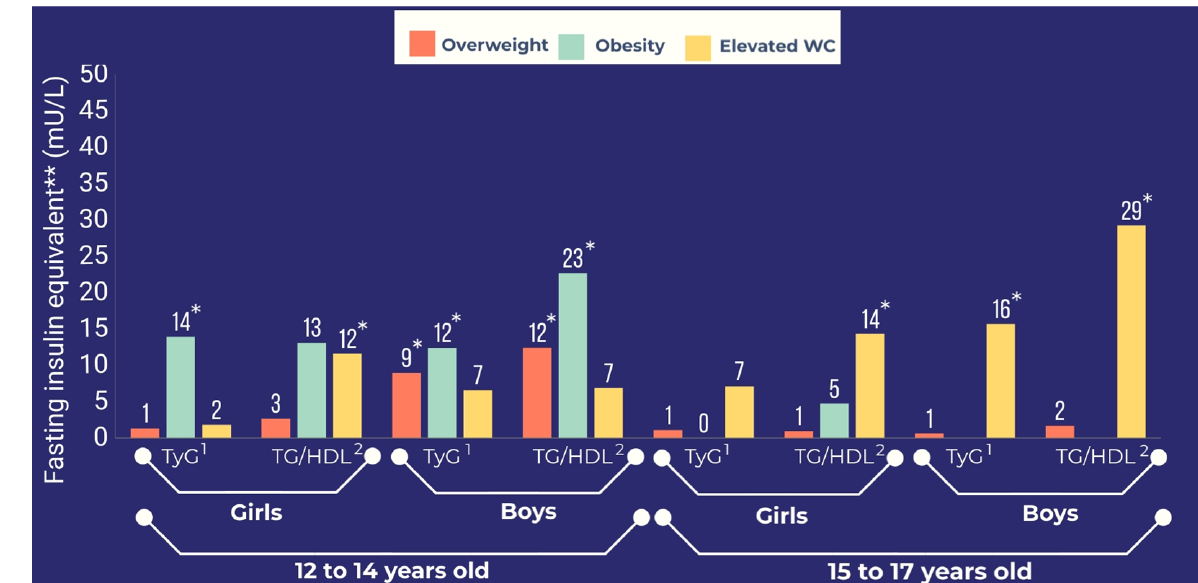
Figure 1. Adjusted ** fasting insulin equivalents for overweight, obesity, and elevated waist circumference for insulin resistance markers according to age and sex in The Study of Cardiovascular Risk Factors (2013–2014) . ** Adjusted for physical inactivity, smoking status, sedentary behavior, alcohol consumption, socioeconomic status, and Tanner stage; 1 triglyceride/glucose index; 2 triglyceride/high-density lipoprotein; * p -value ≤ 0.05.